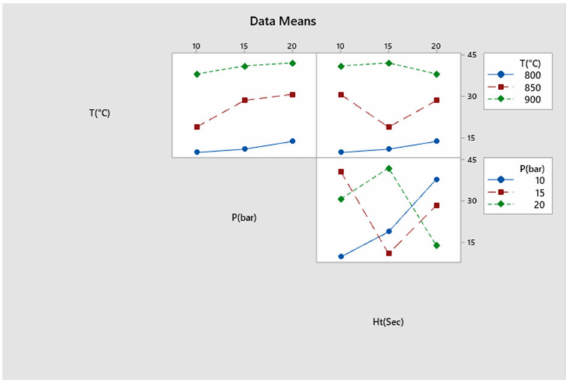
Figure 8. Interaction plots for interface